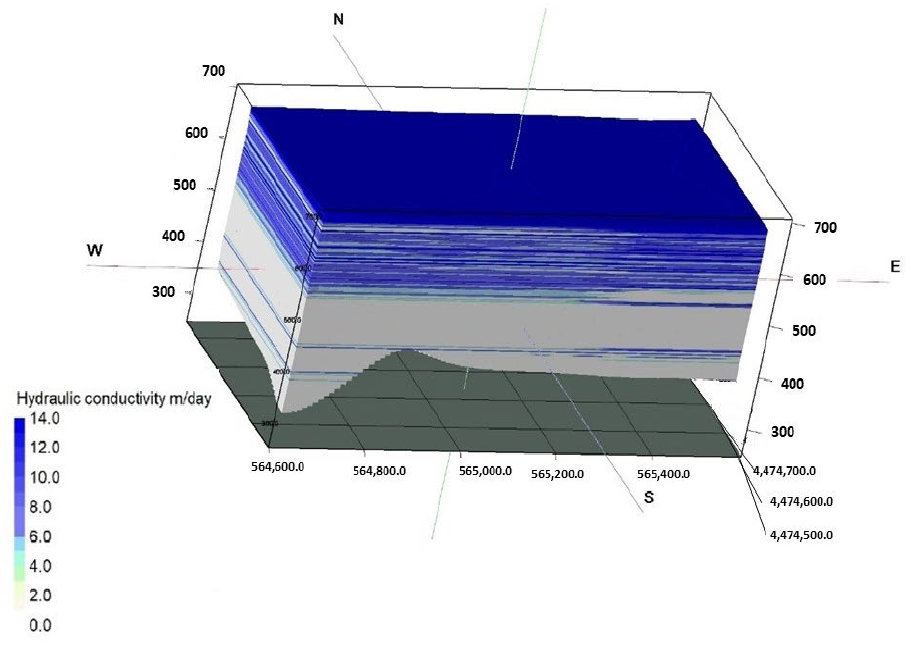
Figure 14. 3D model of the two hydrolithological units in the targeted area, regarding hydraulic conductivity m/day. Vertical axis represent elevation above sea level (a.s.l) values.